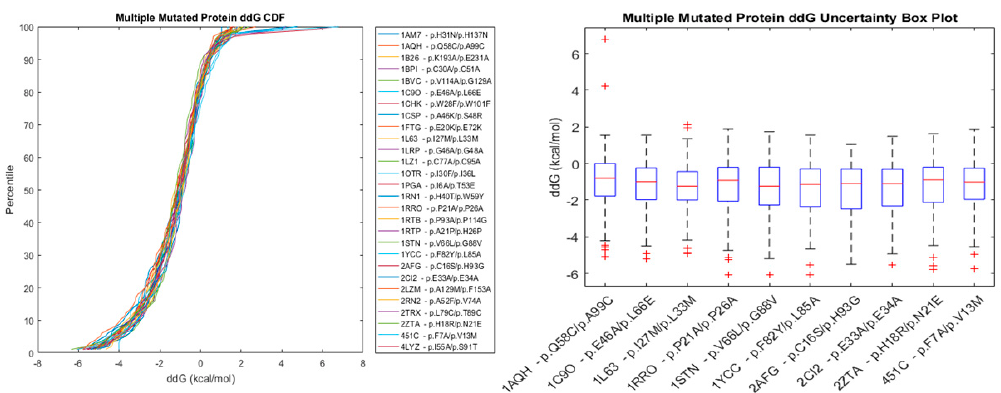
Figure 6. Cumulative distribution function of energy changes and the uncertainty plot for selected proteins with multiple point mutations.